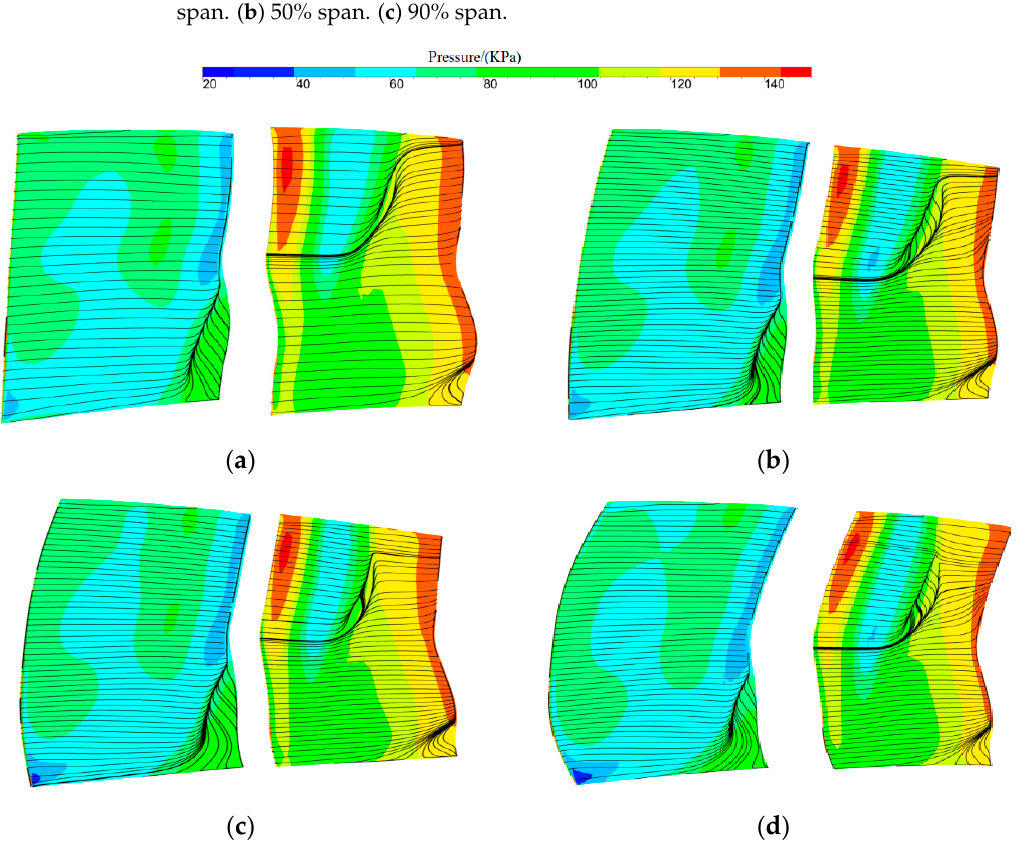
Figure 19. Comparison of static pressure and limit flow line diagram on suction surfaces of PB10, PB20, and PB30. ( a ) ORG. ( b ) PB10. ( c ) PB20. ( d ) PB30.